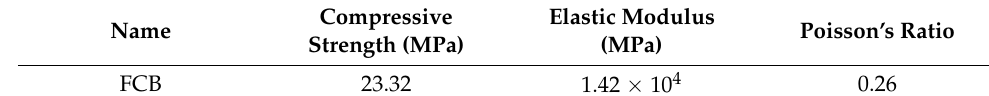
Table 4. Mechanical properties of FCB.